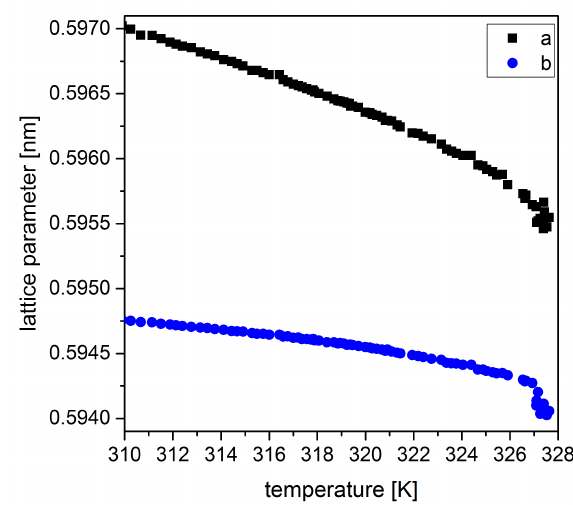
Figure 3. Application example: precisely determined lattice parameters a and b of Ni–Mn–Ga MSM alloy and their evolution while heating. The sudden change denotes the structural transformation